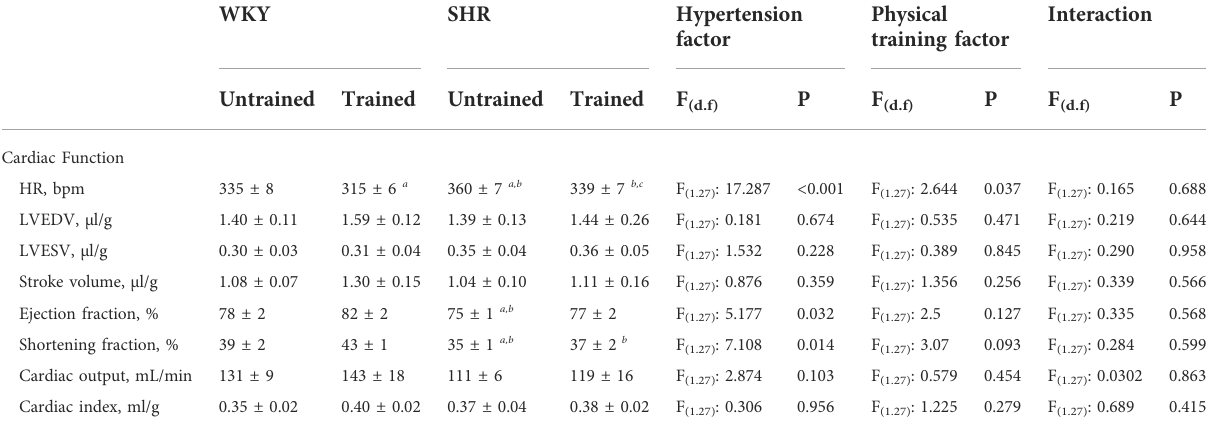
Physical Interaction factor training factor